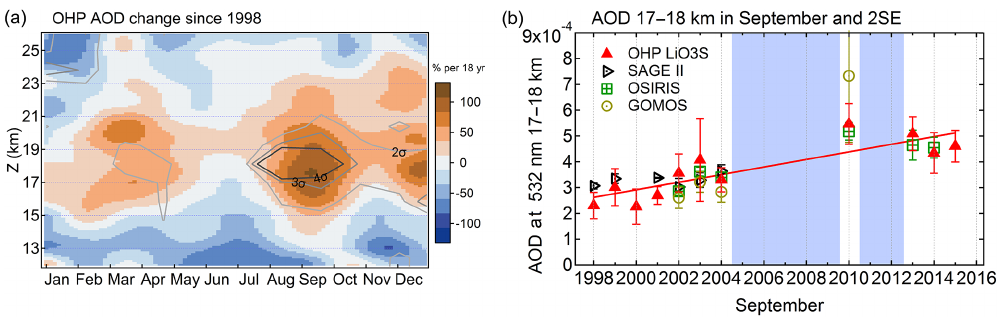
Figure 8. (a) Monthly averaged 1km AOD change since 1998 from the OHP LiO3S lidar based on the observations during volcanically unperturbed periods. Statistically significant changes above the 95% confidence interval are encircled by grey-scaled contours. (b) Evolution of the AOD in the 17–18km layer in September from the OHP LiO3S lidar and satellite observations above the western Mediterranean. Error bars denote 2 times the standard error. Shaded areas indicate the volcanically perturbed